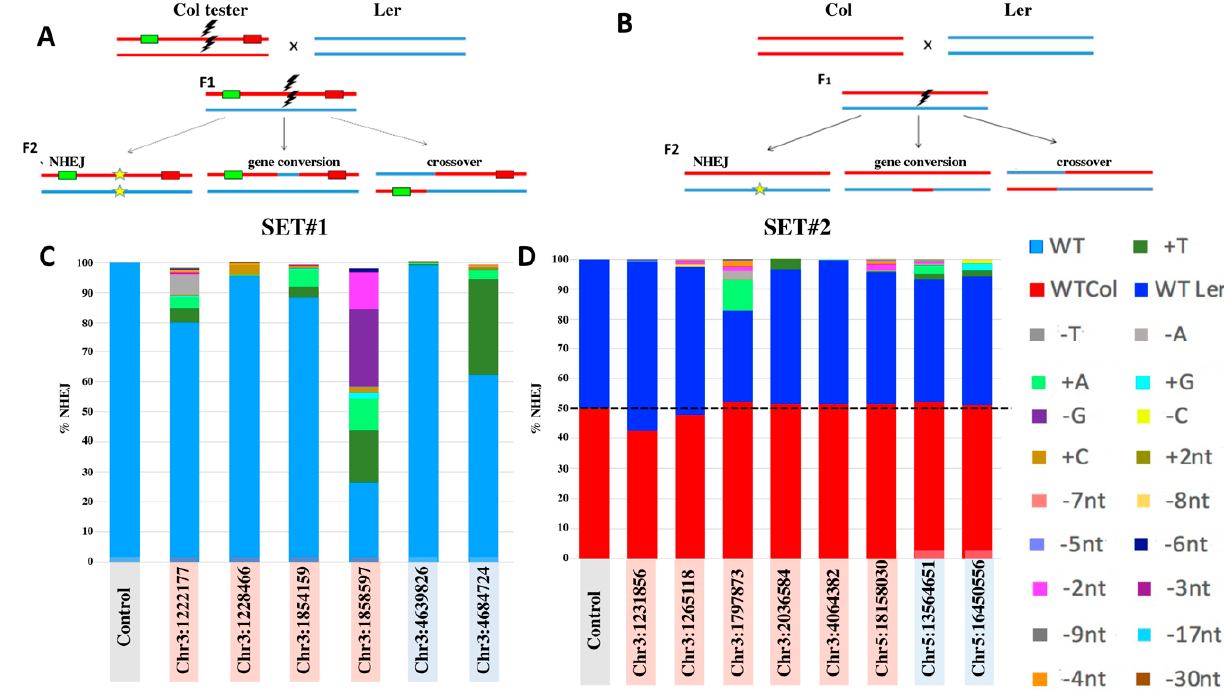
Figure 1. Schematic description of crosses, DSB induction and NHEJ frequency in different targets. ( A ) Experimental scheme for the analysis of somatically induced DNA DSB repair. The Col parent is heterozygote for the meiotic tester Col3-4/20. It is transformed with a construct containing Cas9 and a gRNA that targets a unique site in between the RFP and GFP markers (shown as red and green rectangles, respectively). It was crossed with Landsberg WT plants. In the resulting F1 DSB (lightning) induction can cleave both Columbia and Landsberg chromosomes at allelic targets. Each construct includes a single gRNA belonging to Set#1 (Supplementary Table S1). DNA DSBs can be repaired via NHEJ (recognized as indels indicated by a star), gene conversion, or crossover. The homologous chromosomal segments are shown as a red line for Columbia and as a blue line for Landsberg. ( B ) Plants of Columbia transformed with both Cas9 and a specific gRNA belonging to Set#2 (Supplementary Table S1) were crossed with Landsberg WT plants. In the resulting F1 plants, DSB (lightning) induction is allele specific to Landsberg allele. ( C , D ) show the % of NHEJ for guides of Set#1 and Set#2, respectively. DNA was amplified around the DSB target site and the resulting PCR fragments were sequenced by Illumina platform and the resulting reads analyzed with Cas-analyzer [37]. The NHEJ % represents the percent of reads containing indels out of the total number of reads. Each bar represents an average of the indel frequency of a pool of ~100 F2 seedlings (10 seedlings from 10 plants). In the x-axis each target is shown by its chromosome and coordinates. The red and blue boxes indicate hot (euchromatin) and cold (heterochromatin) targets respectively. The legend at the right describes the color and name of the most prominent footprints.